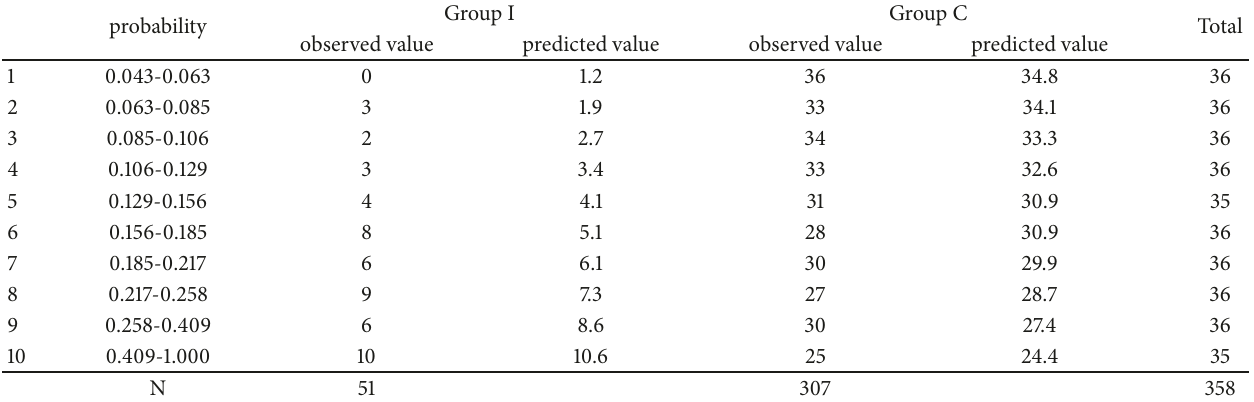
Table 2: Results of propensity score matching.